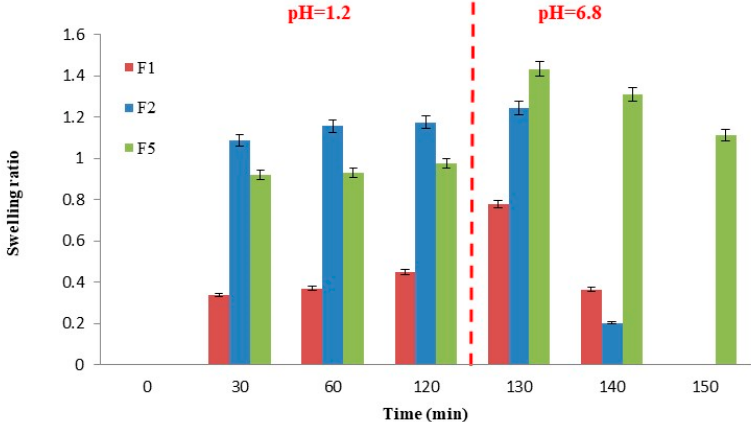
Figure 5. Swelling profiles of formulation F1 and F2 compared to F5. Mean ± S.D.; ( n = 3).